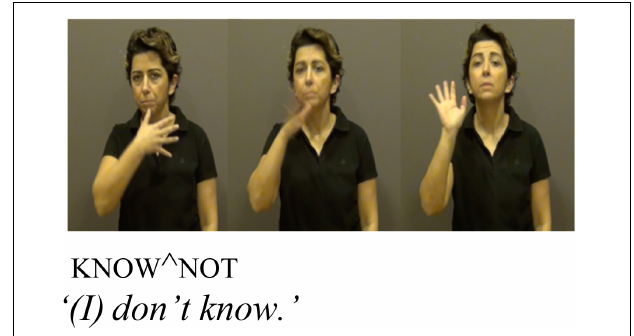
FIGURE 3 | Adapted with permission from Kelepir (2020d: P4, 3.5.1.1).